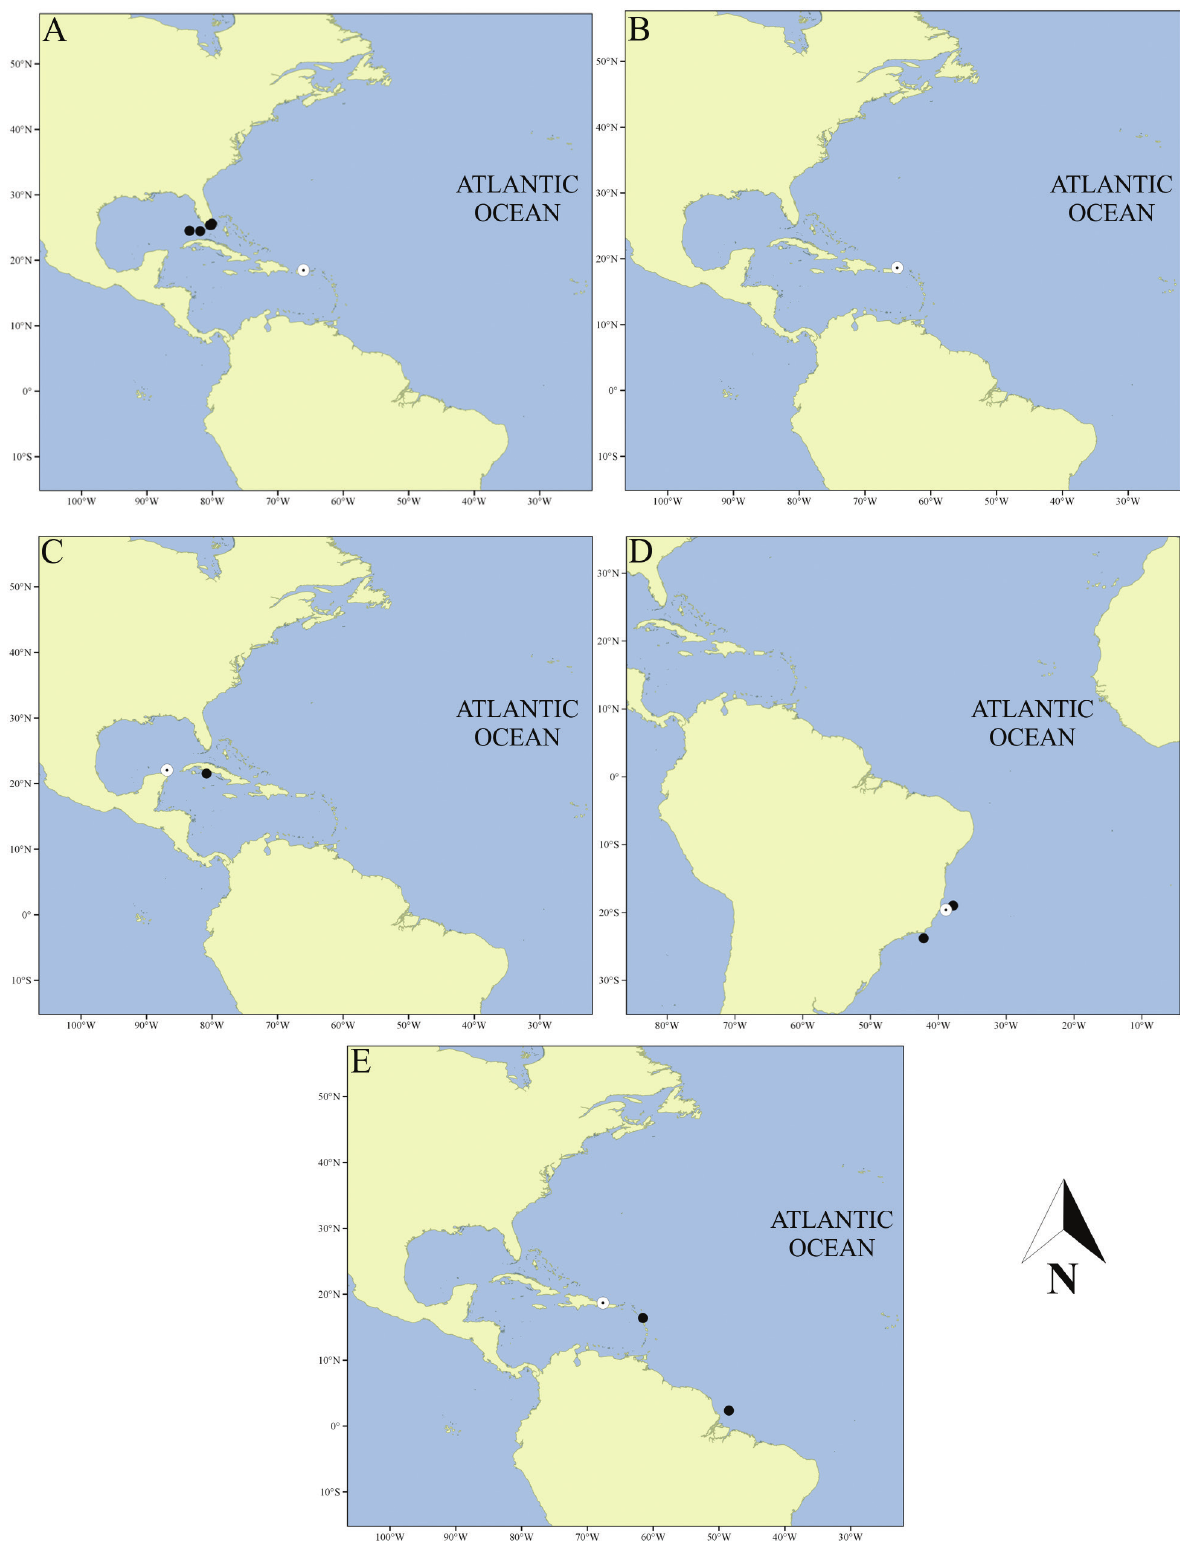
Figure 5. Geographical distributions of Eulimacrostoma spp. based on confirmed identifications. A. Eulimacrostoma microsculp- turata sp. nov.; B. Eulimacrostoma chascanon (Watson, 1883), comb. nov.; C. Eulimacrostoma fusus (Dall, 1889), comb. nov.; D. Eulimacrostoma lutescens (Simone, 2002), comb. nov.; E. Eulimacrostoma patula (Dall & Simpson, 1901), comb. nov. White circle: type locality; black circle: additional records. Records without geographic coordinates are